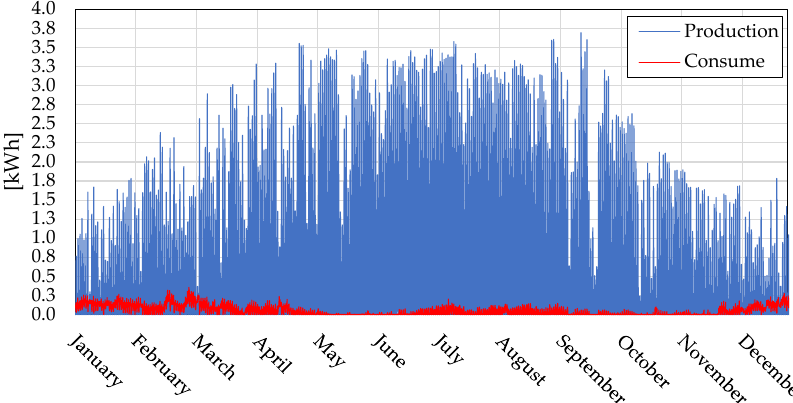
Figure 21. Hourly electric energy production and electric split demand.